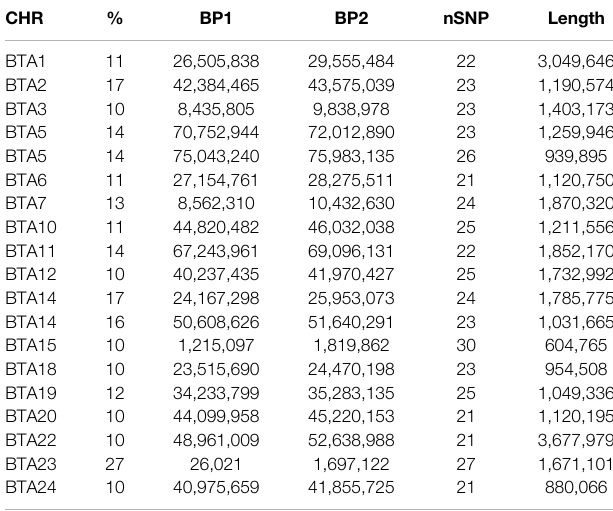
TABLE 4 | Heterozygous-enriched regions (HER) which appear in at least 10% of Purunã individuals. CHR